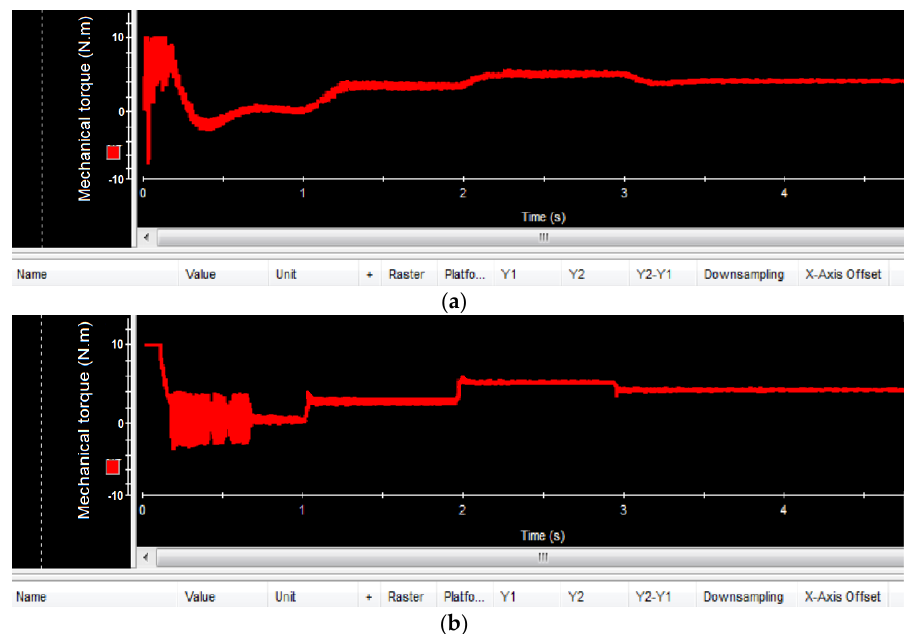
Figure 31. Experimental motor-developed torque under ( a ) fuzzy PID based PSO and ( b ) C-BO- based fuzzy PID. fuzzy